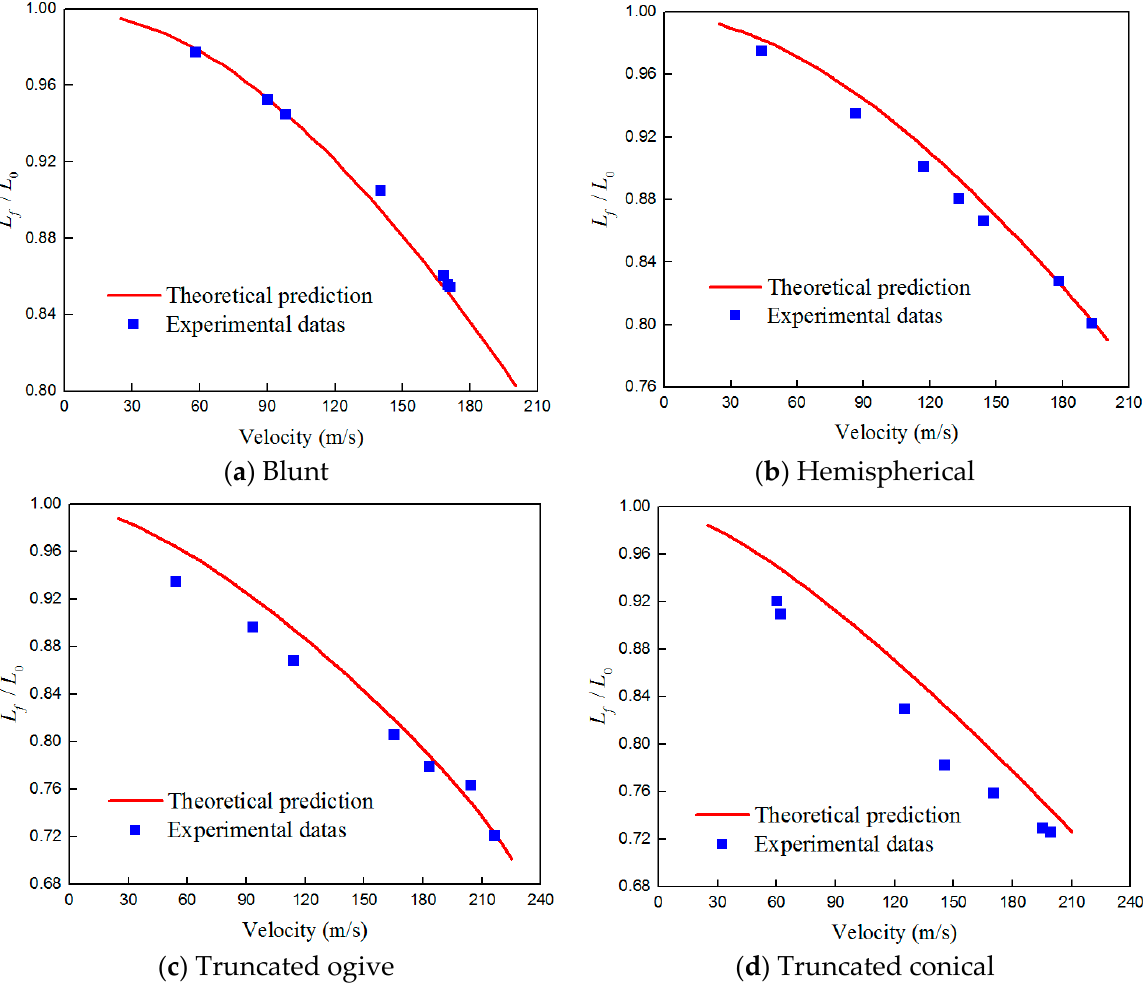
Figure 23. Comparison of theoretical prediction (red line) and test data (blue squares) for the residual length of the pro- jectiles.